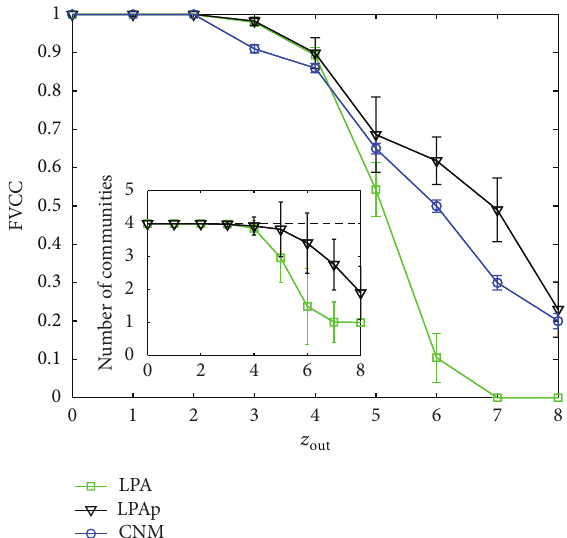
Figure 8: FVCC of CNM, WLPA, and LPAp on weighted computer- generated networks.